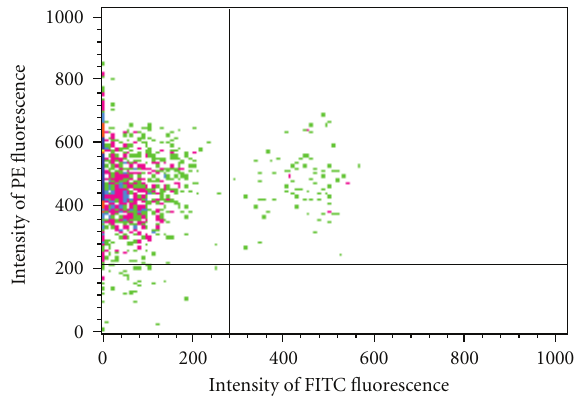
Figure 2: Greater surface density of CD9 on the GCs (measured as mean intensity of CD9-PE fluorescence) correlated with lower fertilization rates in mature oocytes ( r = − 0 . 372, P = . 04). See the text for the definition of mature oocytes. The Model II regression is y = − 0 . 27 x + 152 . 8